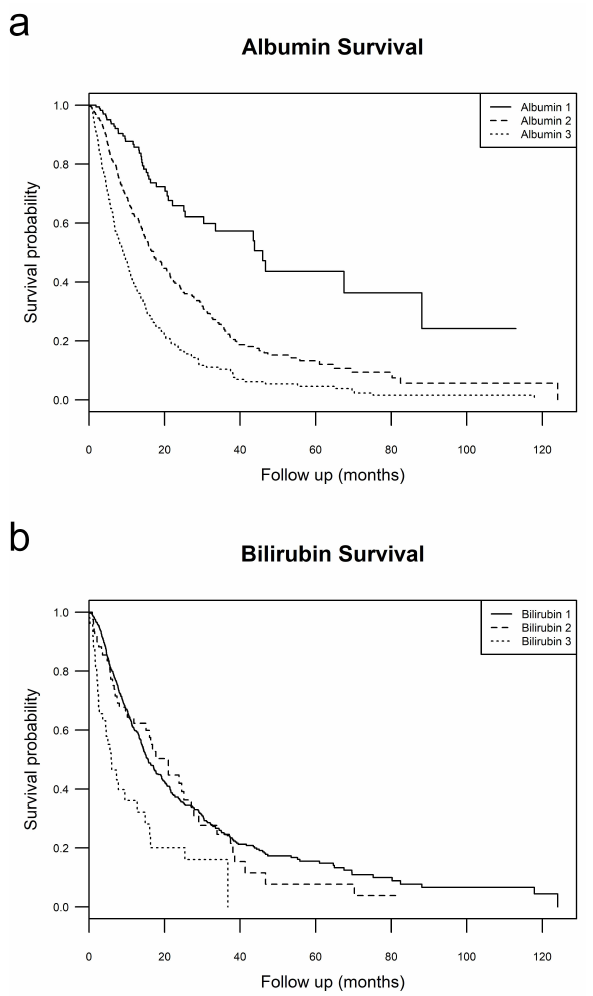
Figure 1. Albumin and bilirubin Survival. ( a - top ) Kaplan Meier survival curves of all patients stratified by albumin grade; ( b - bottom ) Kaplan Meier survival curves of all patients stratified by bilirubin